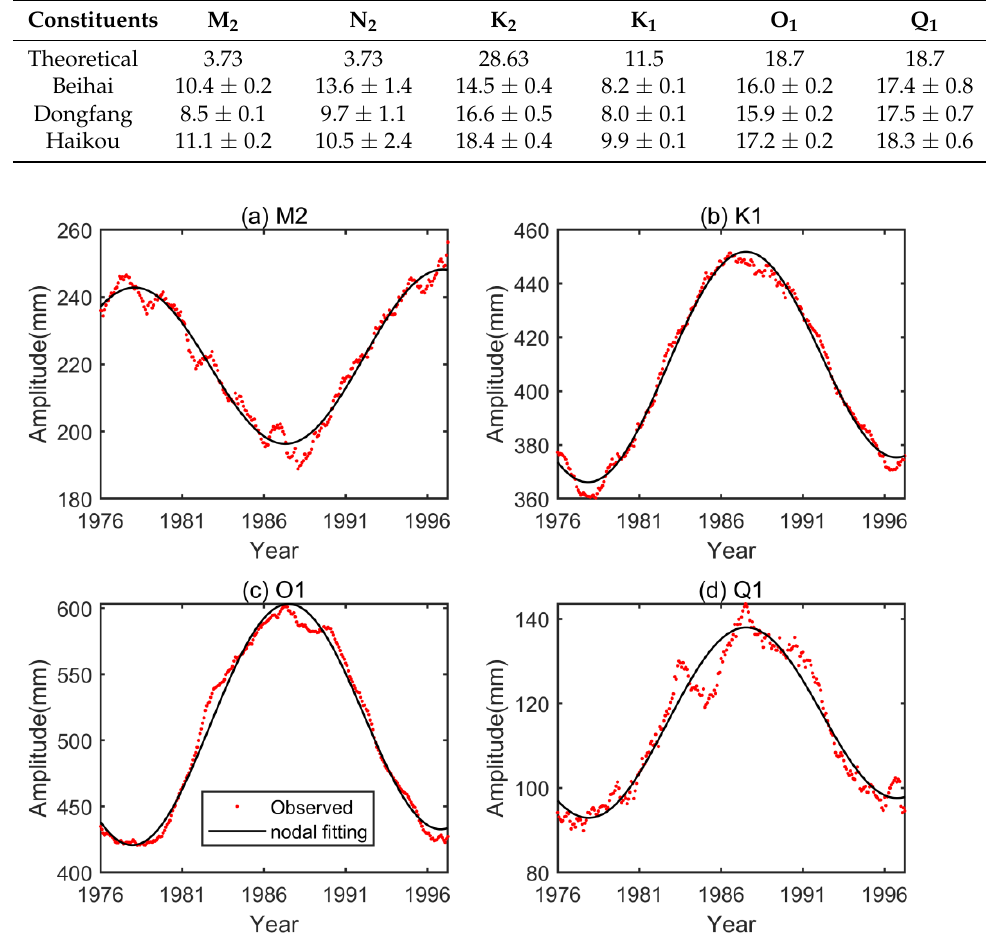
Figure 3. Tidal amplitudes (red dots) and their nodal fitting results (black lines) at Haikou. ( a ) M2 ( b ) K1 ( c ) O1 ( d ) Q1.